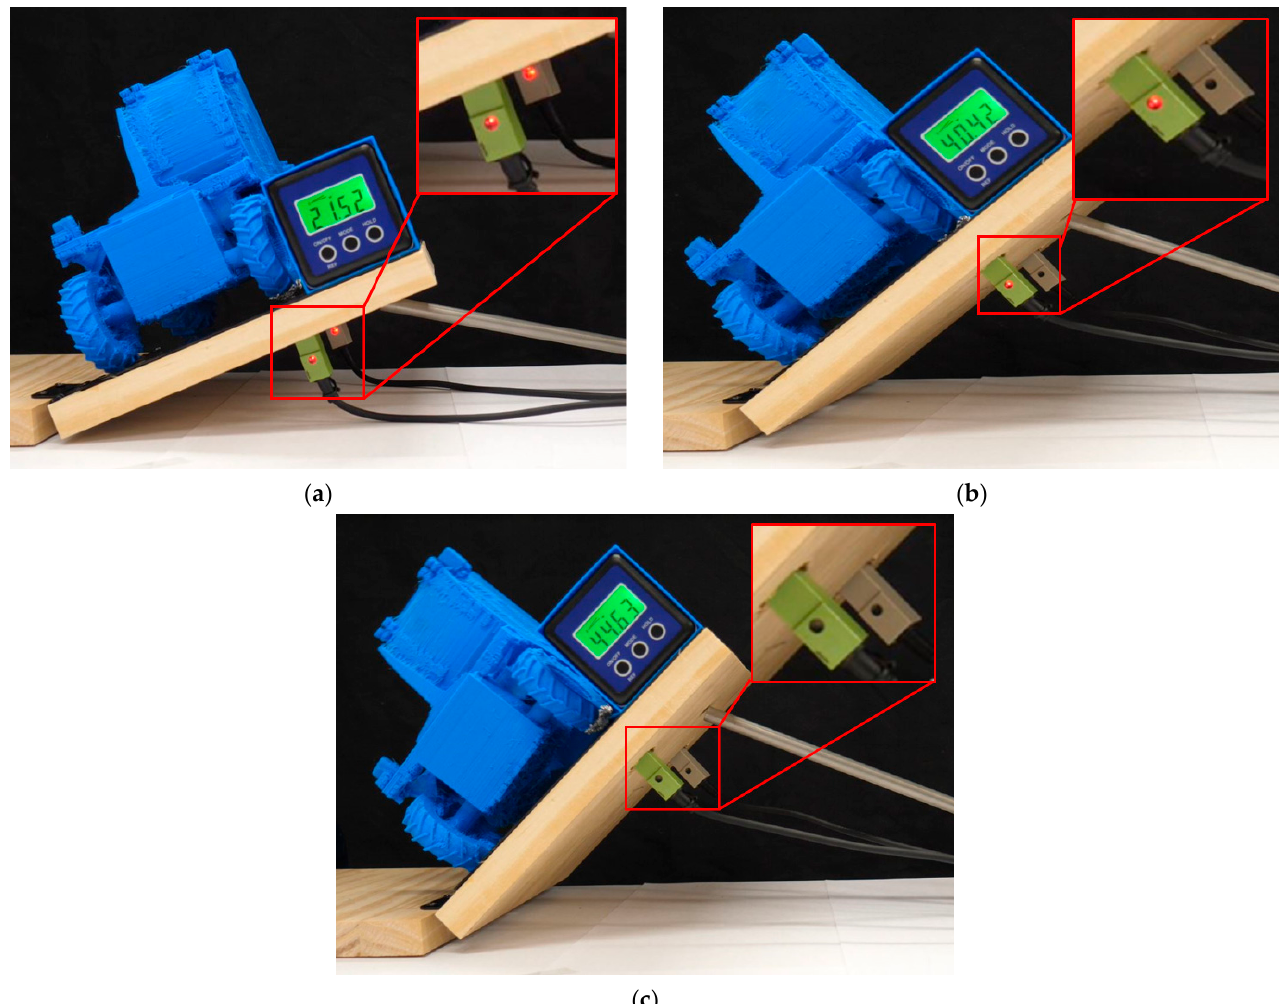
Figure 10. Lateral overturning test using the developed miniature model and test platform: ( a ) Contact of both wheels; ( b ) Falling off of the rear wheel and contact of the front wheel; ( c ) Falling of both wheels (then lateral overturning occurred rapidly).